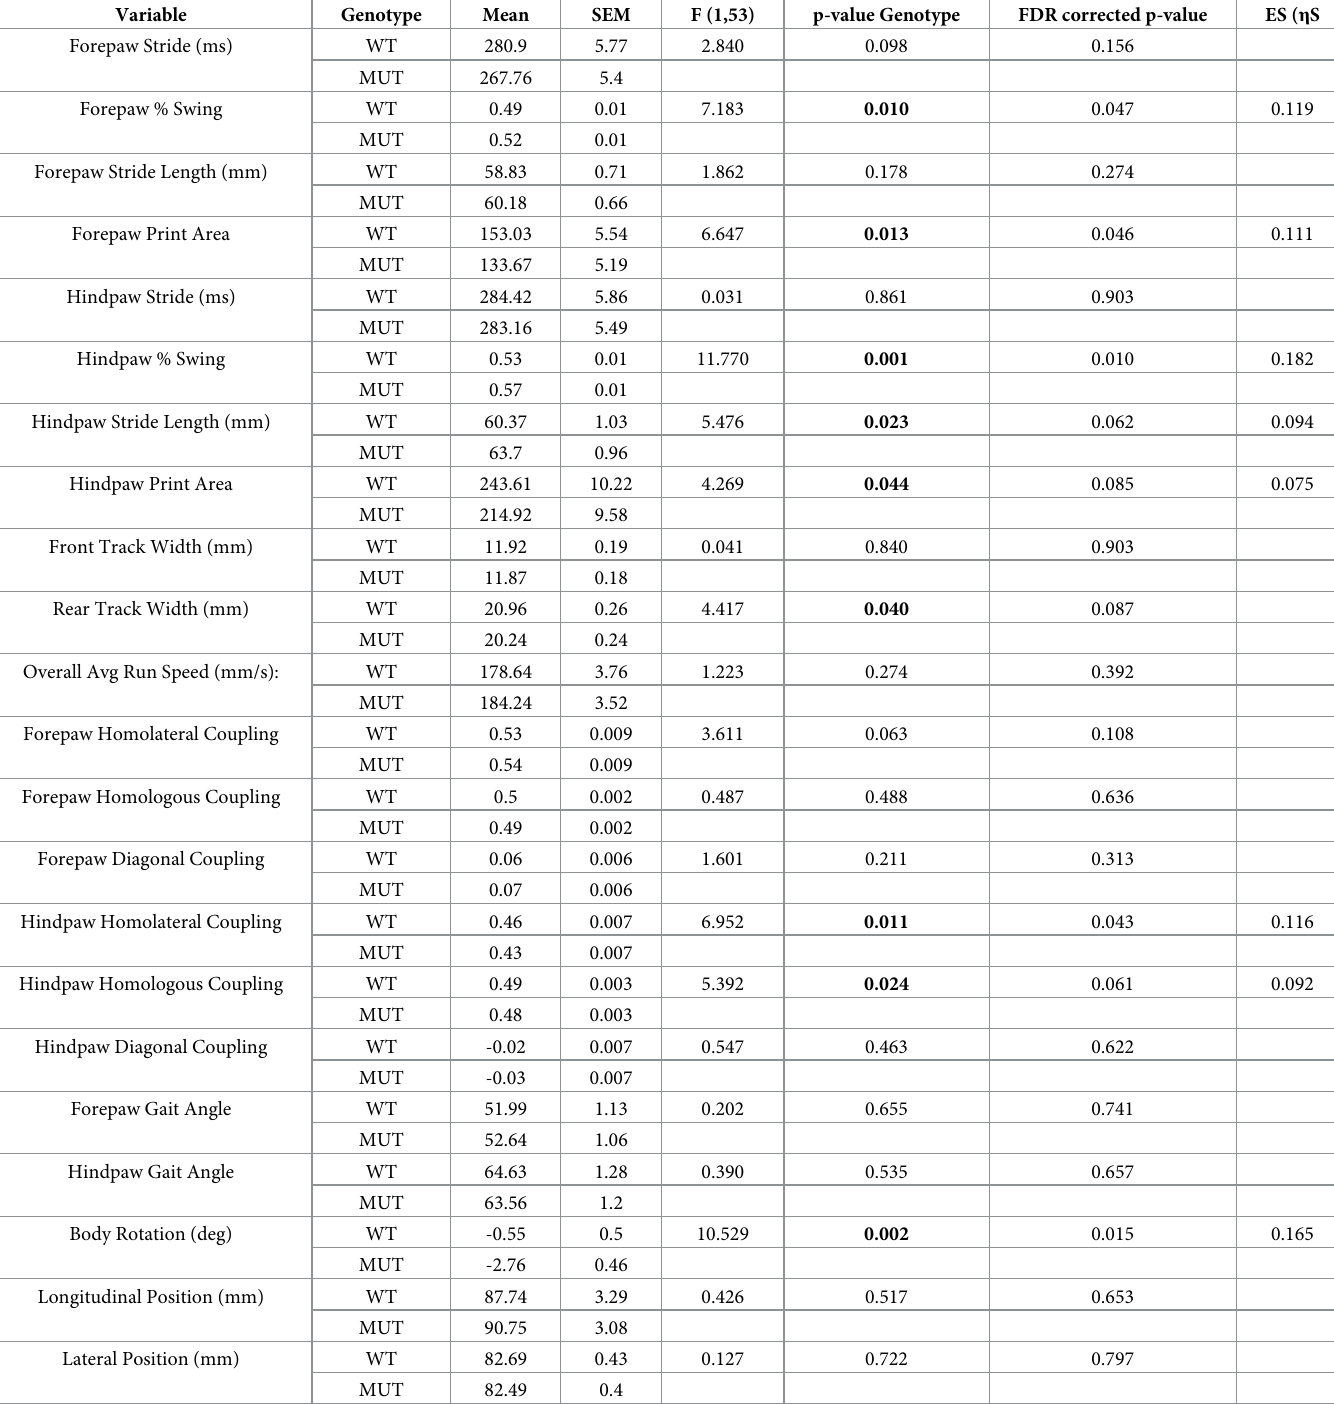
Table 2. Foxg1 MUT/WT mice have a variety of changes in gait parameters. Animals were evaluated at 9–12 weeks of life. WT n = 26, FoxG1 MUT/WT (MUT) n = 30. Signif- icant differences for uncorrected p < 0.05 bolded. FDR corrected p-values are presented next to uncorrected p-values. Effect size (ES) is reported (partial η 2 ) for significant differences observed with uncorrected